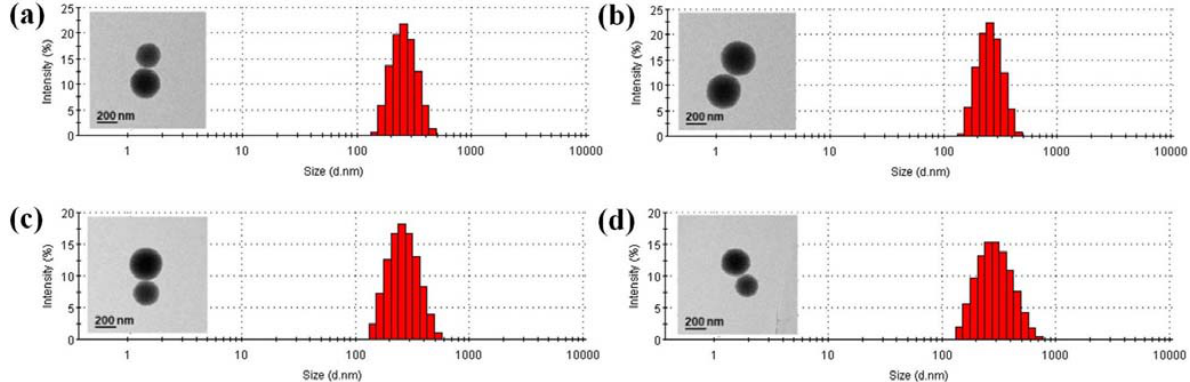
Figure 1. Size distribution curves of ( a ) MSNs, ( b ) TA-MSNs, ( c ) LF (10 µ g)/TA-MSNs, and ( d ) LF (50 µ g)/TA-MSNs. Inset: TEM images of each group. Scale bar: 200 nm.